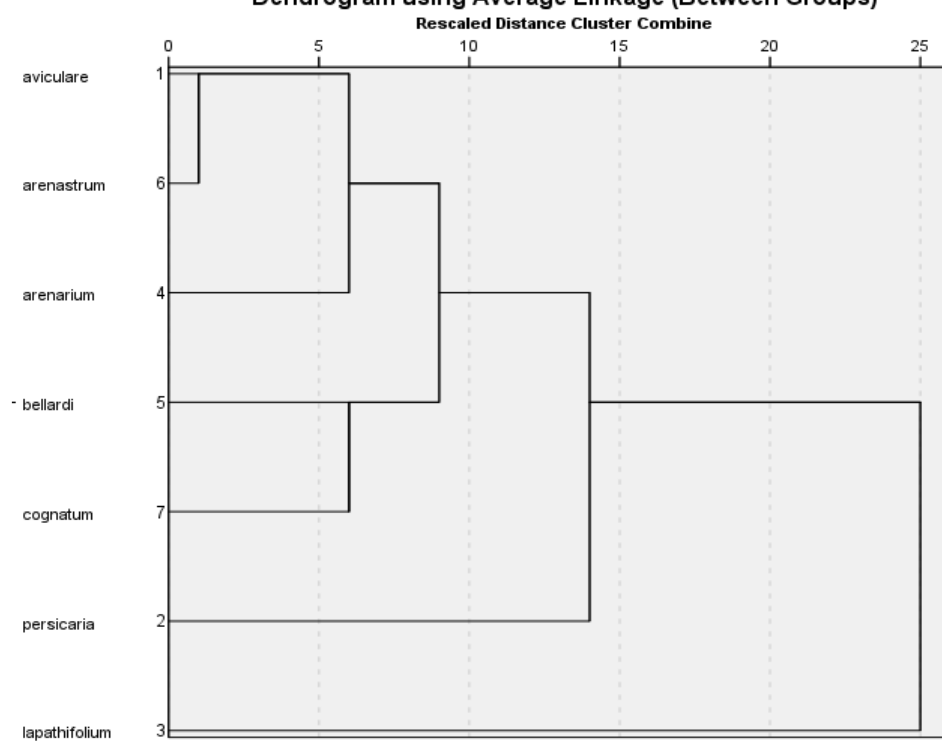
Figure 1. Clustering analysis of seven Polygonum species to essential oil components.